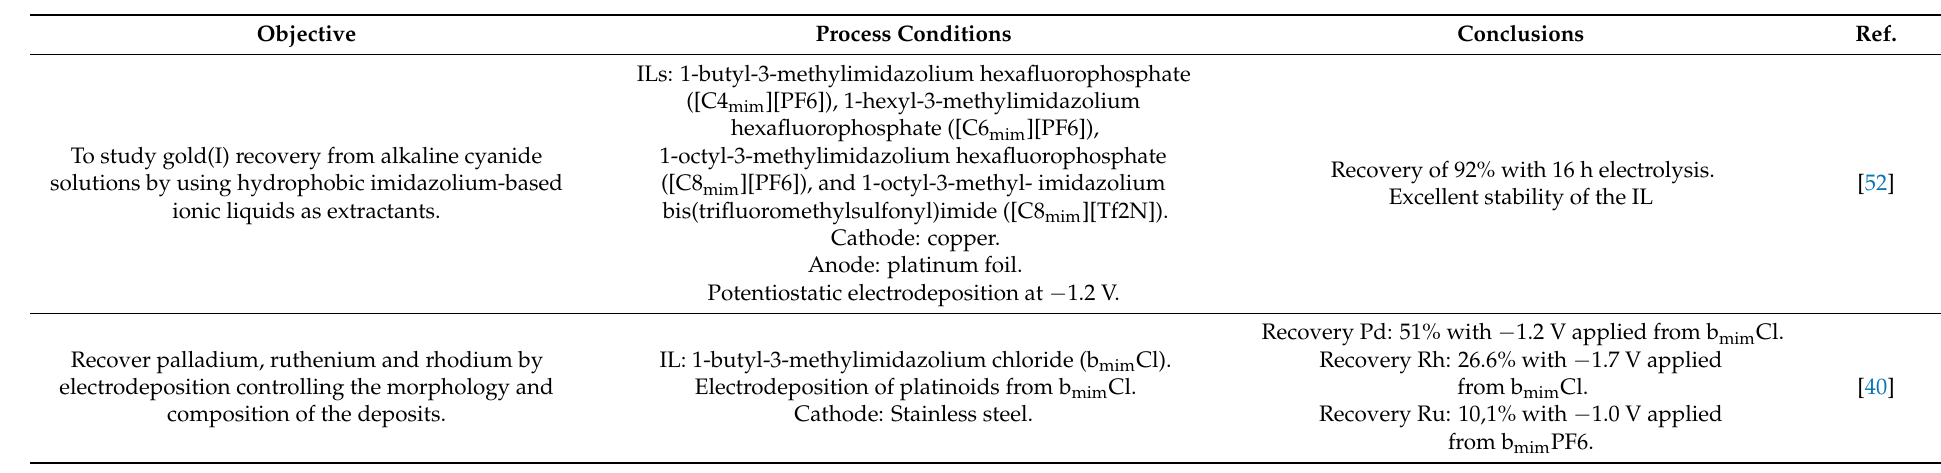
Table 2. Cont. Objective Process Conditions Conclusions Ref.